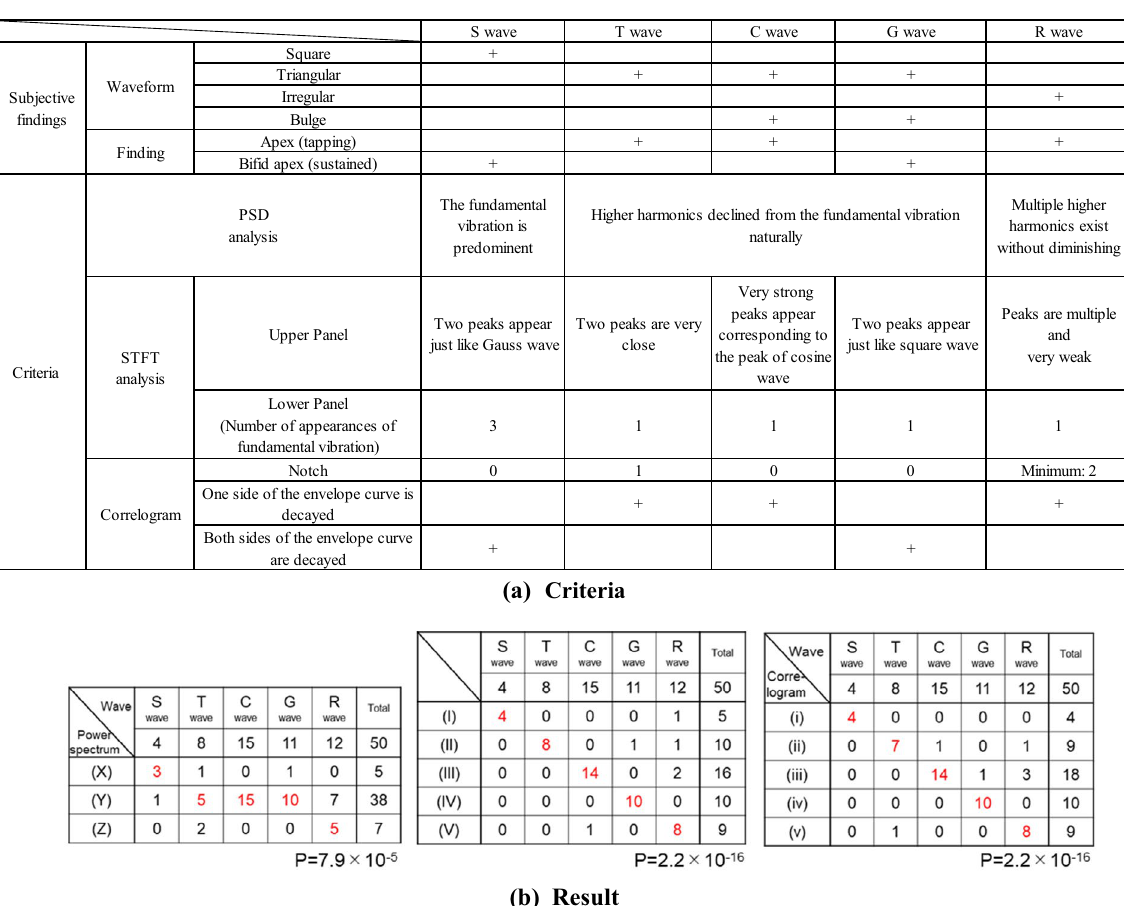
(b) Table 1. Classification of Front CAB (0.5-BF) waveform. (a) The upper half of the Criteria table indicates the classification points by visual inspection of Front CAB (0.5-BF). We conducted analysis of each waveform, using PSD (power spectral density) when focusing on amplitude, STFT on amplitude and phase, and a correlogram to check if they have periodicity. We classified the waveforms in accordance with the criteria described in the lower part of the table. (b) This shows that the visual classification of the waveforms of Front CAB (0.5-BF) corresponds quite well to classification by PSD analysis, STFT and correlogram.